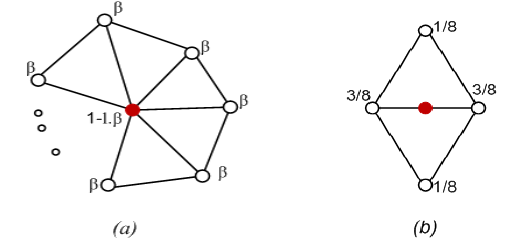
Figure 1. Masks of the Loop subdivision for: (a) vertex-vertices and (b) edge-vertices.